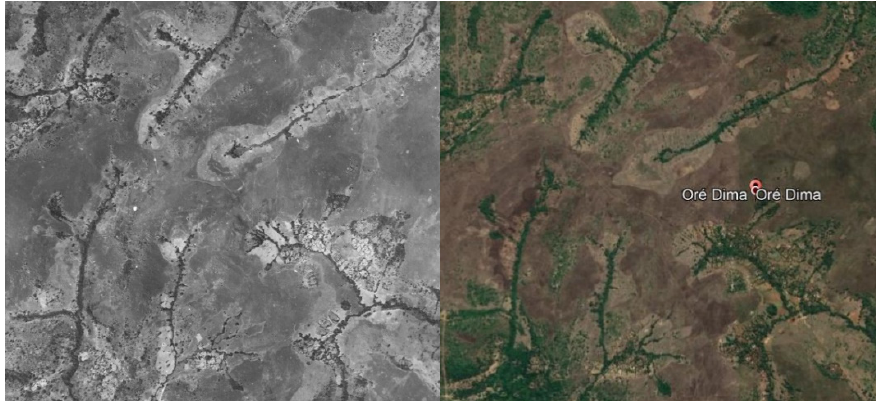
Figure 11. The so-called “three sources” area (15 km northward from Labé, the main city of the Fouta Djallon) in 1953 (IGN, left ) and in 2019 (Google Earth © , right ). No apparent deforestation. The extension of the picture is 5 km from the west to the east by 4.5 km from the north to the south. The area represented is the one of the red square in Figure 7.